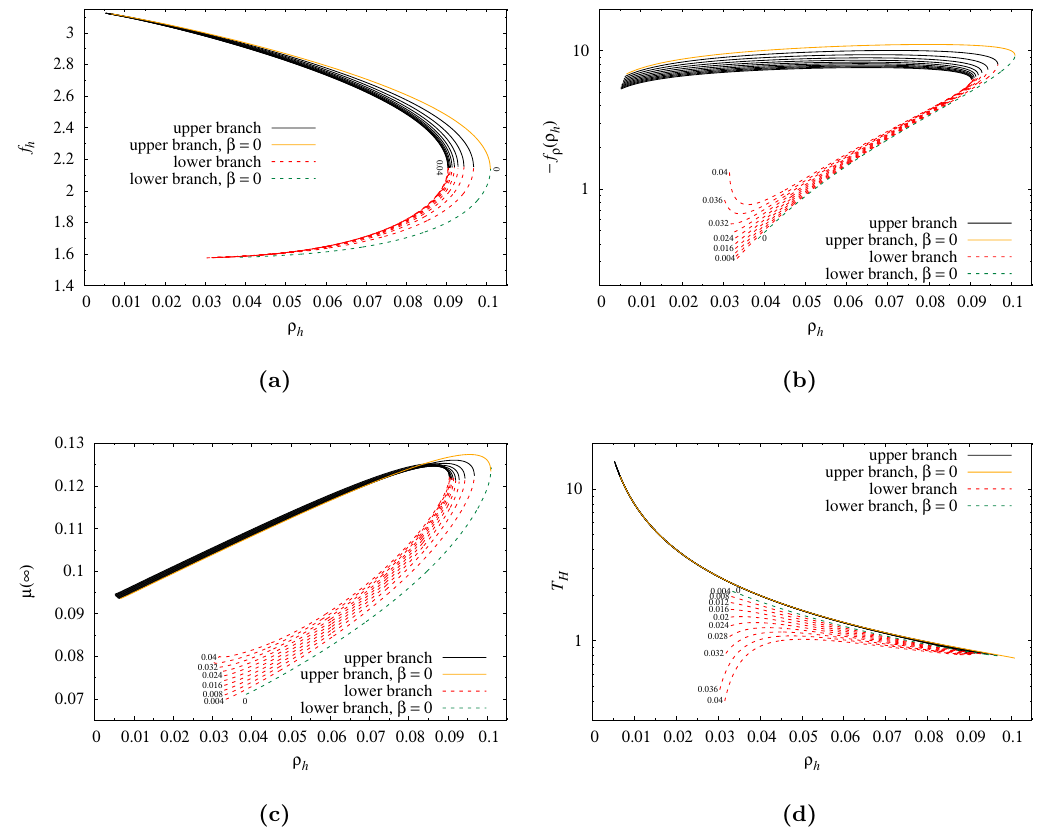
Figure 14 . Details of upper (black solid lines) and lower (red dashed lines) branches of solutions in the 2+4+12 model: (a) the value of the pro(cid:12)le function at the horizon, f h ; (b) the derivative of the pro(cid:12)le function at the horizon, f (cid:26) ( (cid:26) h ); (c) the ADM mass, (cid:22) ( 1 ); (d) the Hawking temperature T H , all as functions of the size of the black hole, i.e. the horizon radius, (cid:26) h . The numbers on the (cid:12)gures indicate the di(cid:11)erent values of (cid:12) = 0 ; 0 : 004 ; 0 : 008 ; : : : ; 0 : 04. The upper and lower (cid:12) = 0 branches are shown in orange and dark green colors,